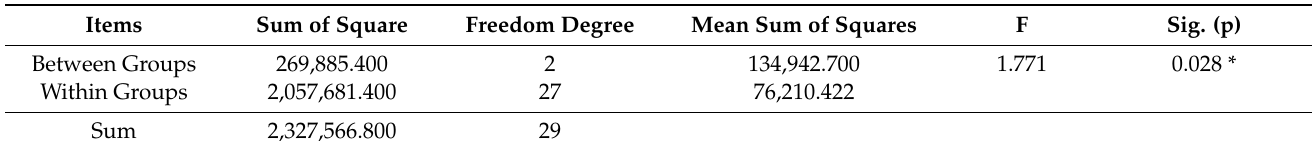
Table 8. Homogeneity test of variance of the time spent on wayfinding tasks for three different age groups. Levene Statistics